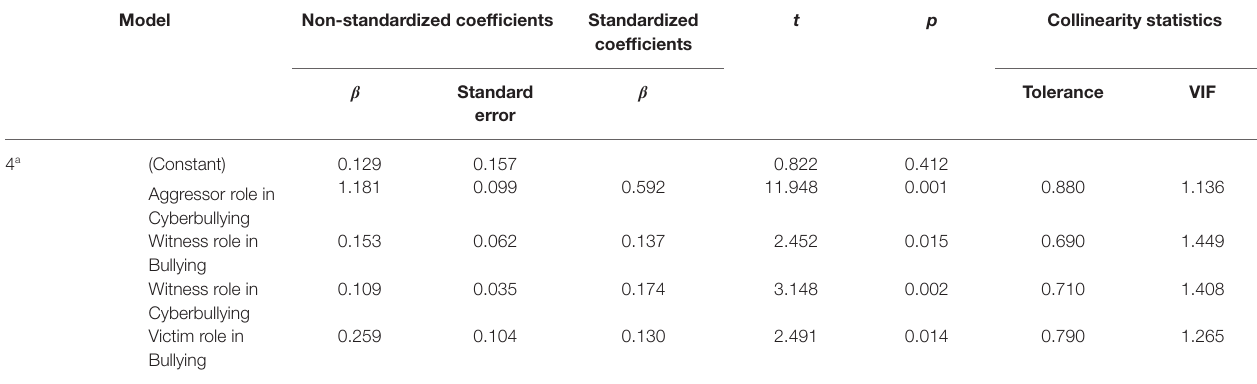
TABLE 2 | Coefficients in the Multiple Linear Regression Model equation.